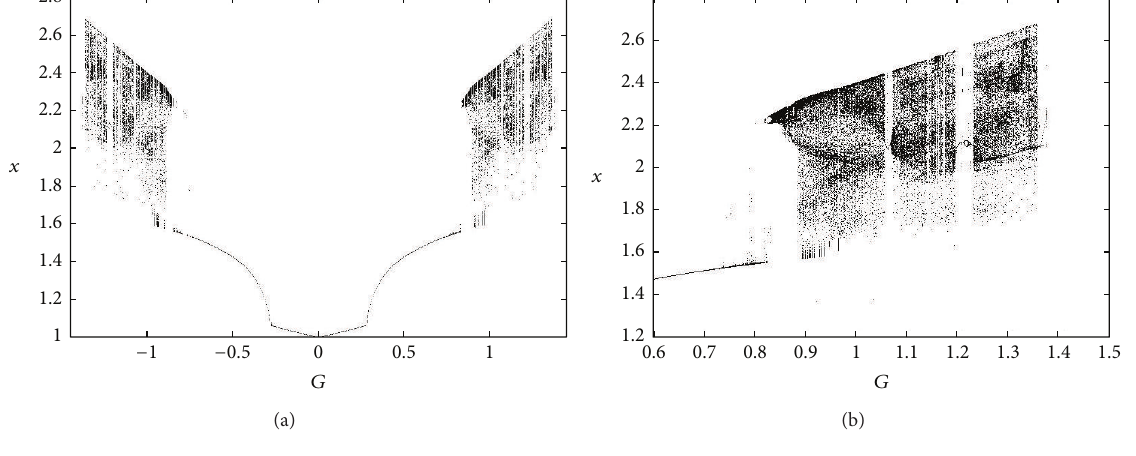
Figure 5: The bifurcation diagram about 𝐺 .